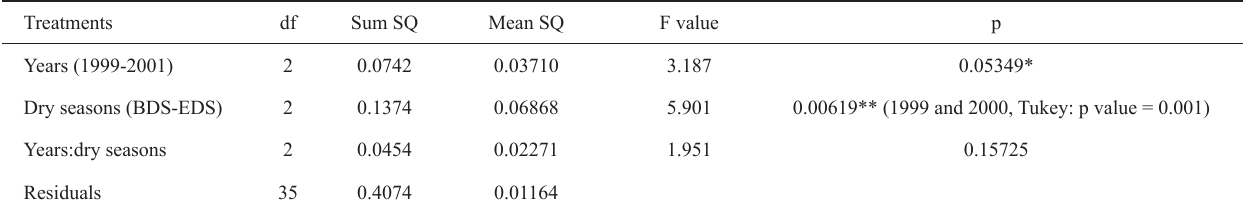
Table 3. F values from ANOVA two-way analysis for population data of Eigenmannia vicentespelaea . BDS-EDS, interaction between beginning of dry season and end of dry season; df, degrees of freedom; Sum SQ, sum of squares; Mean SQ, mean of squares; p, level of significance; *close to significant values; **significant